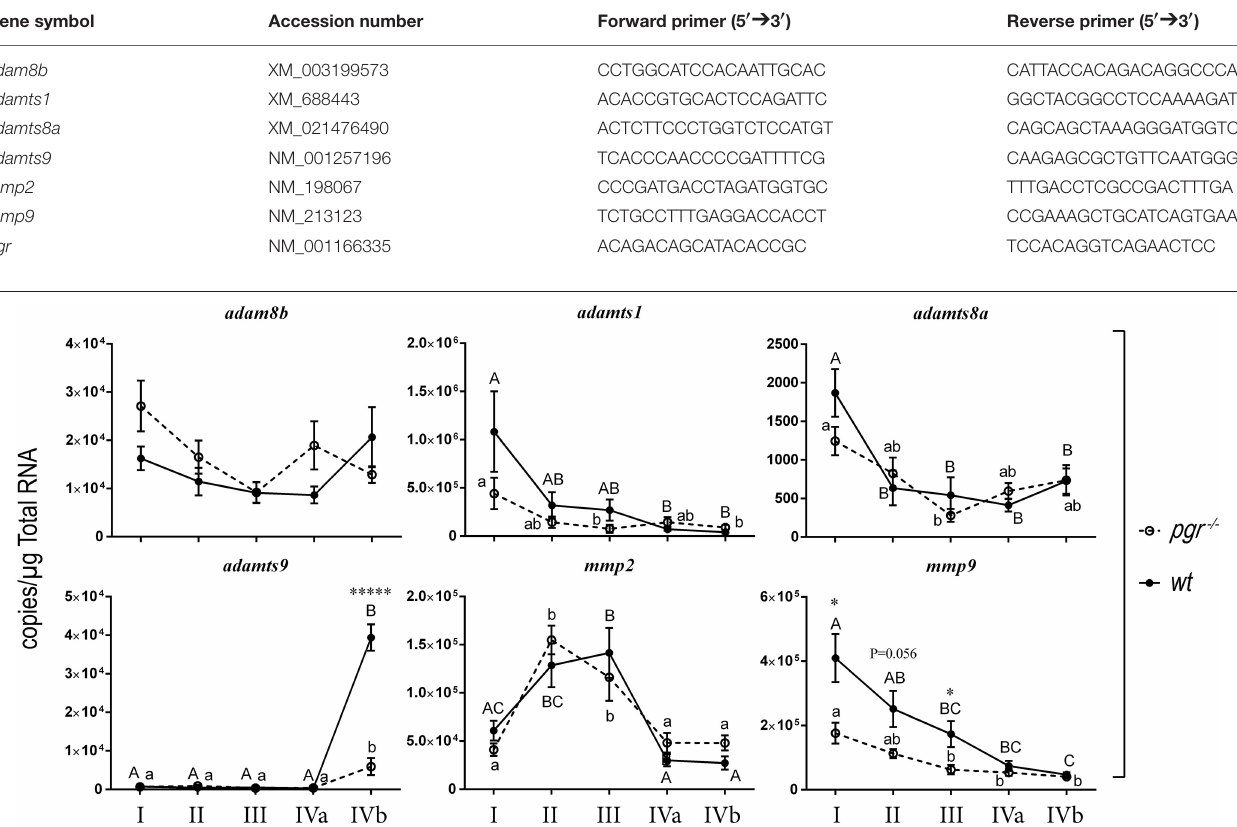
TABLE 2 | Primers used in the study.